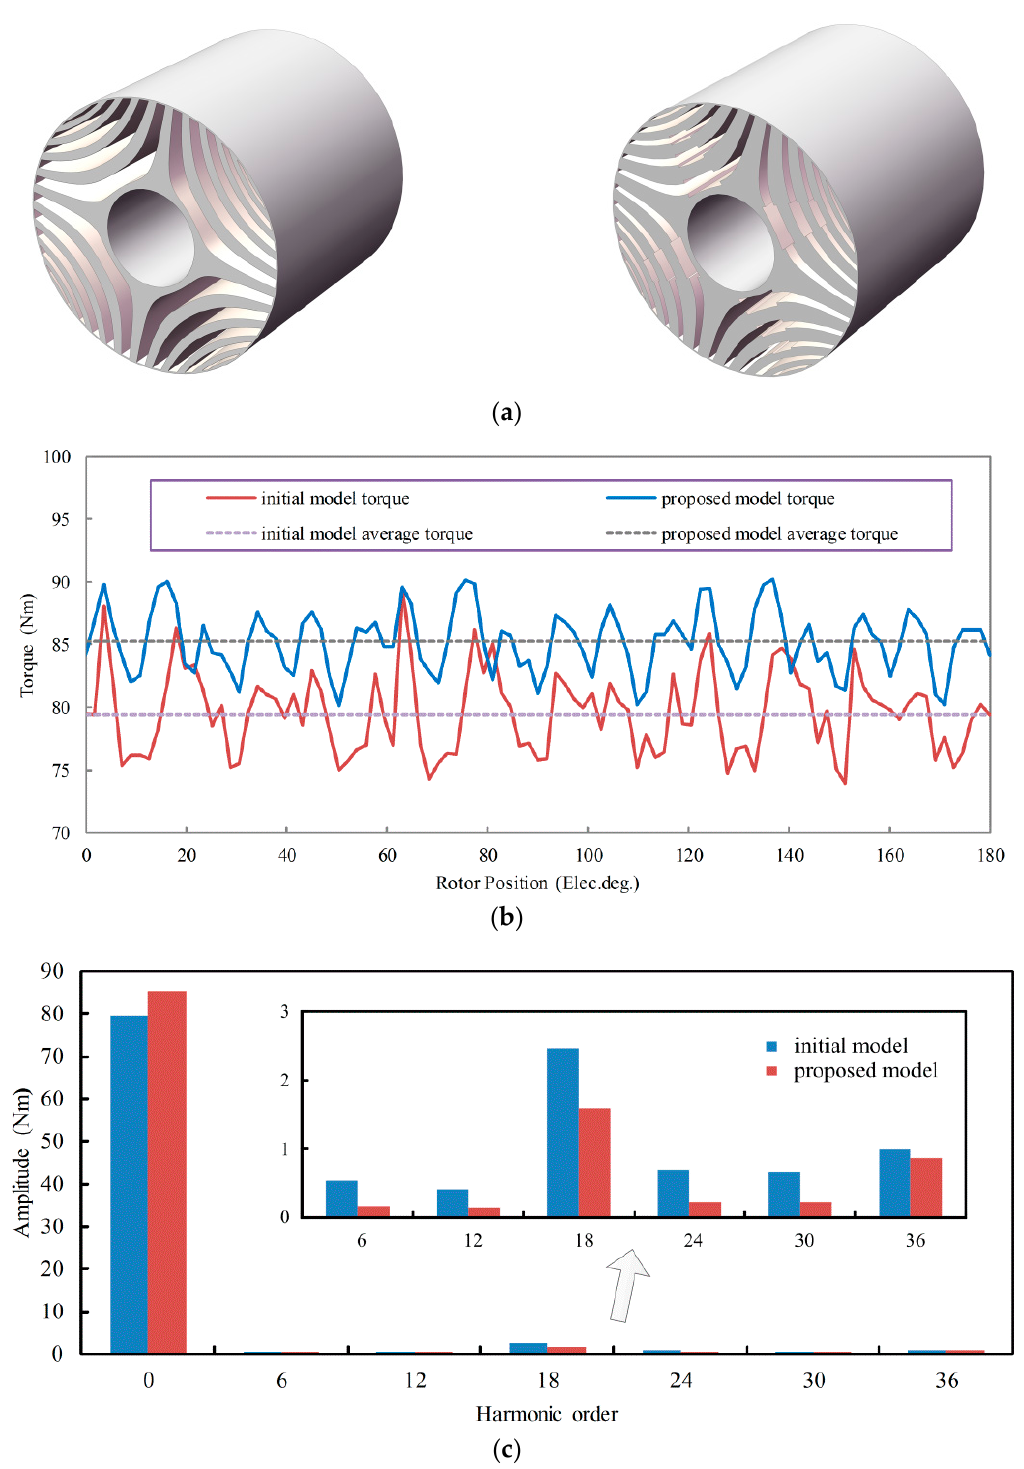
Figure 12. Comparison of the rotor structure and the torque waveforms: ( a ) 3D view of the rotor of initial motor ( left ) and proposed motor ( right ); ( b ) torque waveforms at rated current 21.79 A; ( c ) torque harmonic.